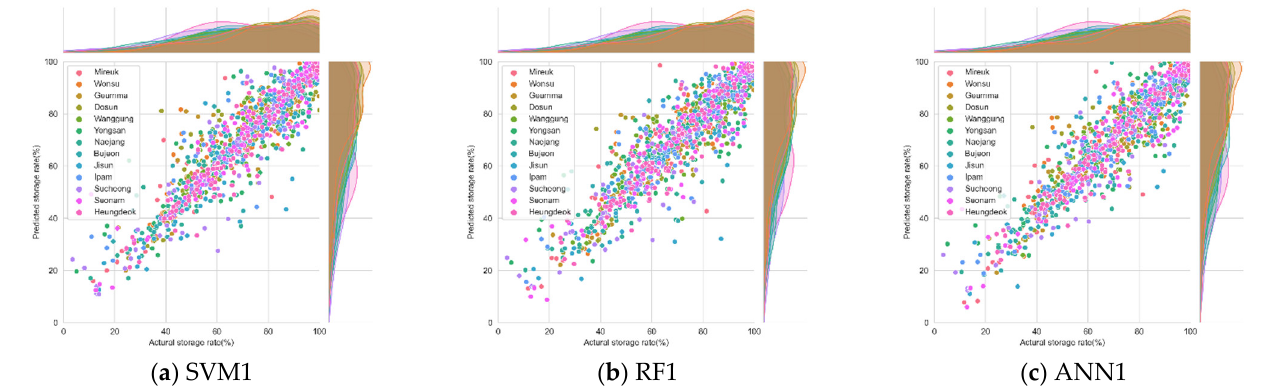
Figure 4. Scatter plots of the observed and predicted monthly storage rates using ( a ) SVM, ( b ) RF, and ( c ) ANN algorithms (one-month forecast). Table 6. Results of best parameters and learning time of models for one-month forecasting.